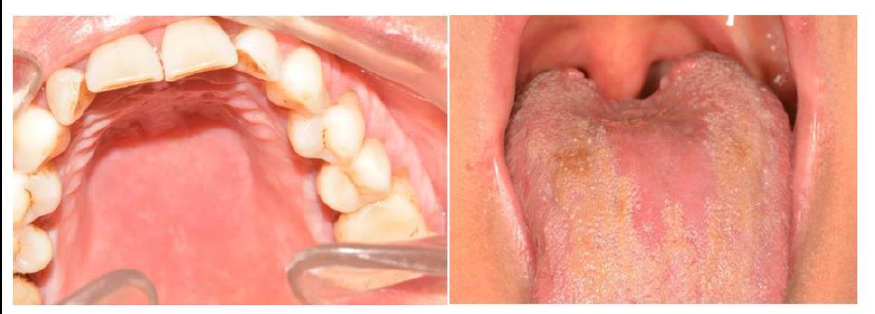
Figure 4. Clinical feaures of oral lesions after therapy. The brownish areas on the tongue are due to povidone-iodine pigmentation and persisted